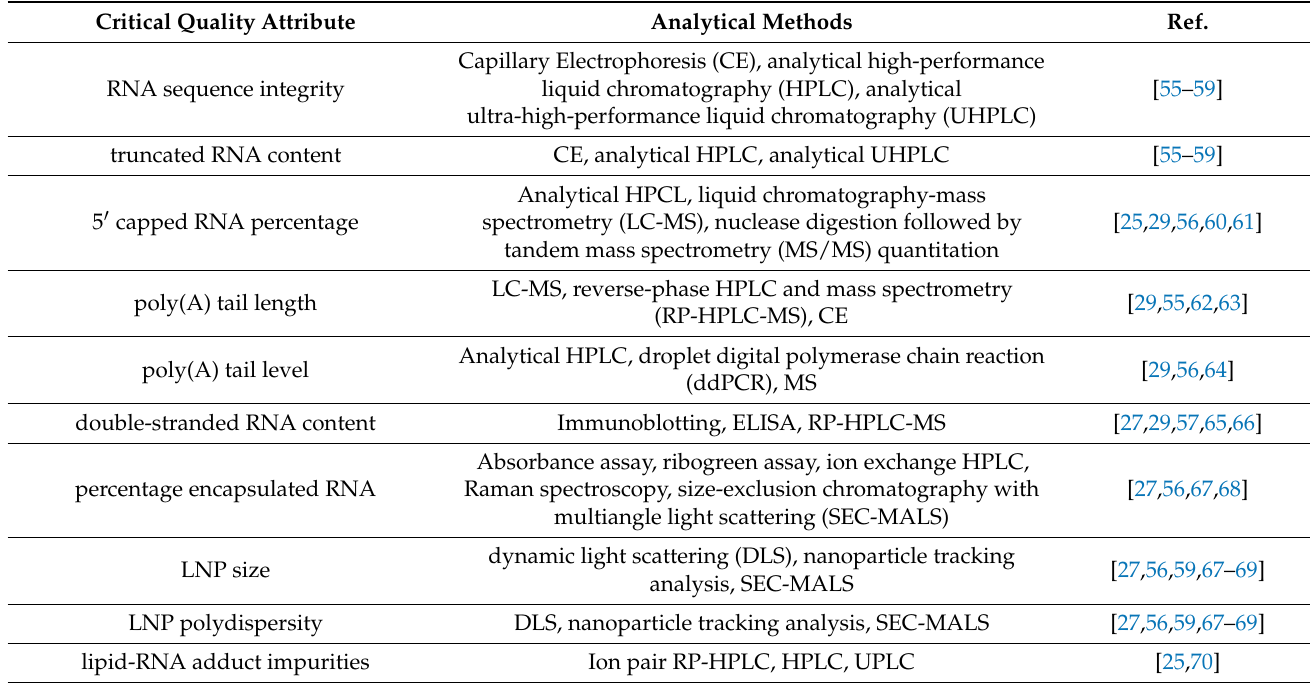
Table 3. List of mRNA-LNP vaccine critical quality attributes related to stability and the analytical methods required to quantify